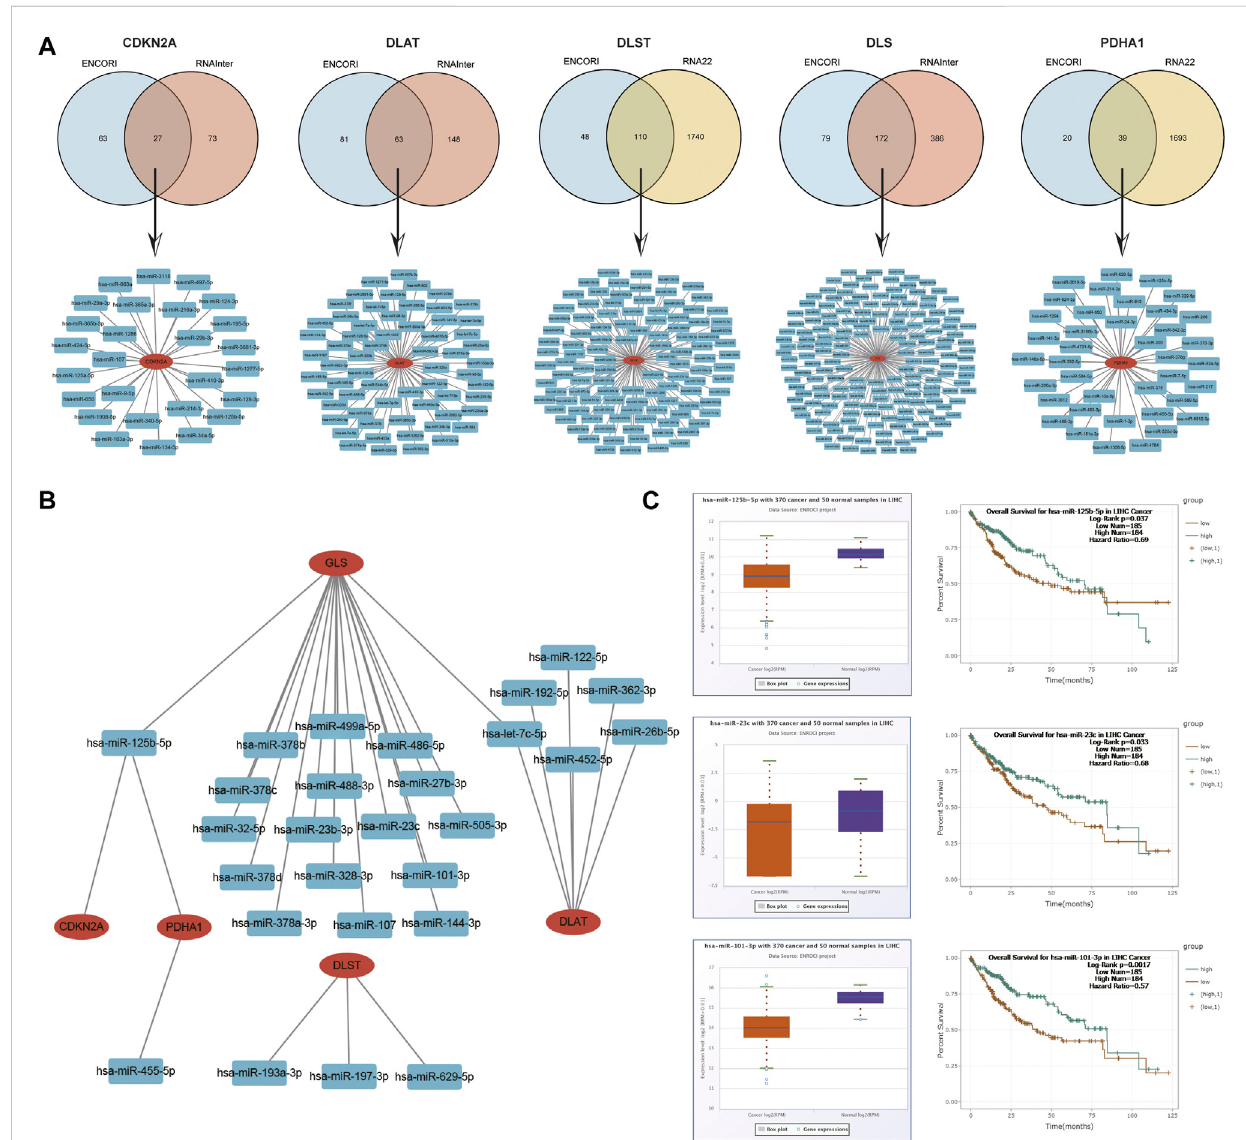
FIGURE 14 Identi fi cation of the potential miRNAs related to the prognosis of HCC. (A) Potential predicted miRNAs associated with CRGs by ENCORI, RNAInter andRNA22databases. (B) PotentialmRNA-miRNAgenenetworksconstructedusingCytoscapesoftware. (C) ExpressionandprognosticvalueofmiRNAs (hsa-miR-125b-5p, hsa-miR-101-3p and